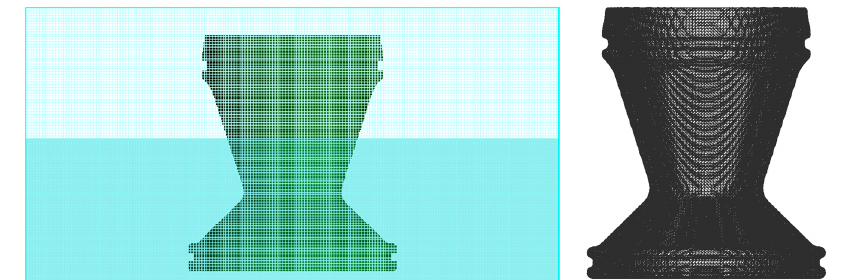
Figure 3. Grid of the case.